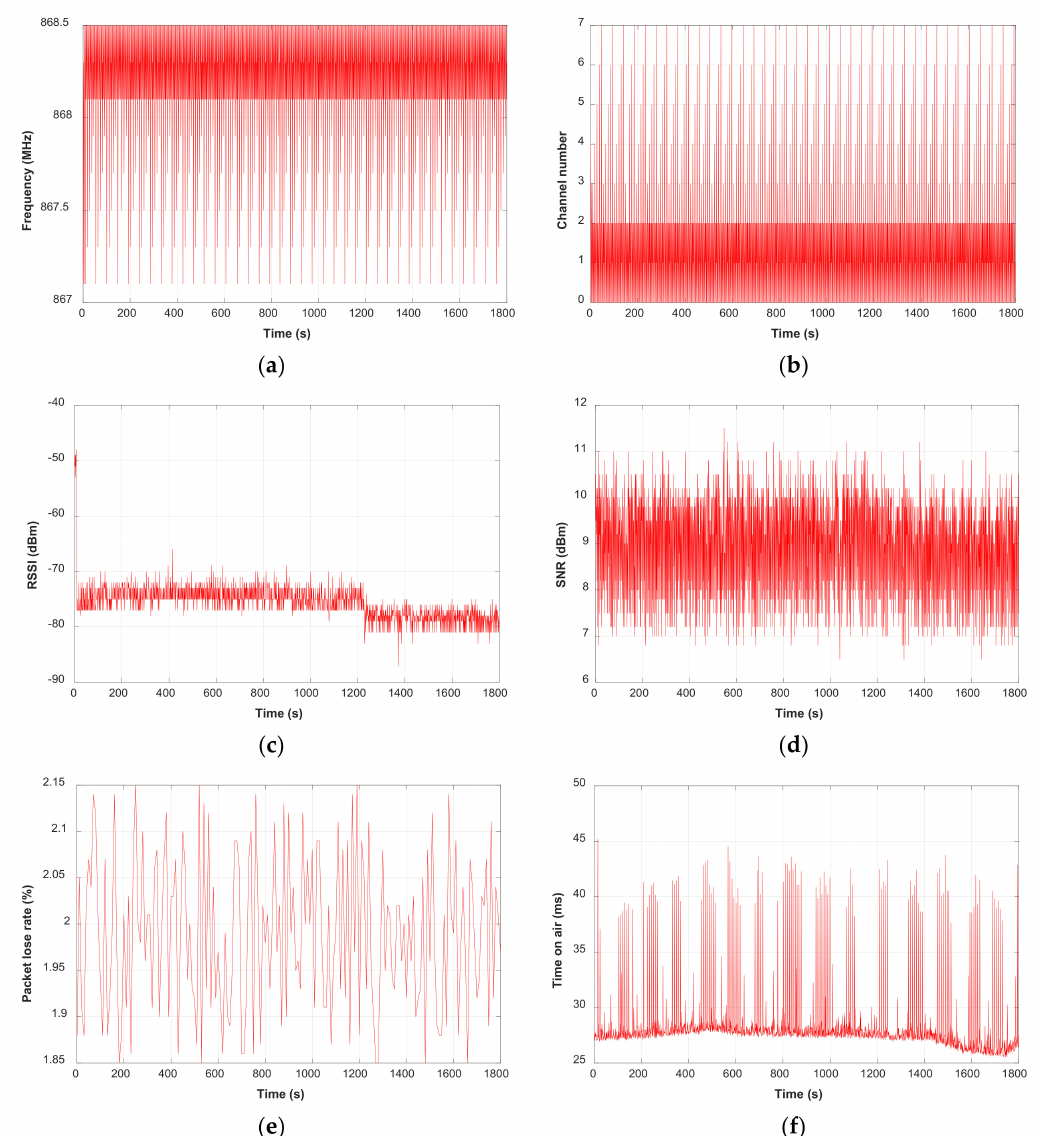
Figure 11. Measurements on the LoRa network: ( a ) Frequency; ( b ) Channel number; ( c ) Receive Signal Strength Indicator (RSSI); ( d ) Signal Noise Ratio (SNR); ( e ) Packet Loss Ratio (PLR); and ( f ) Time on